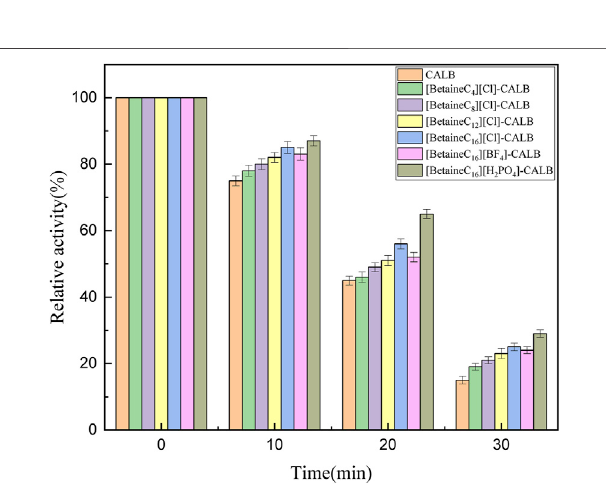
FIGURE 4 | Thermal stability of native and modi fi ed CALBs at 70 °